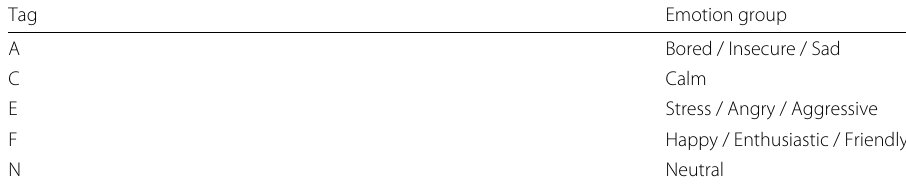
Table 3 Emotion groups abbreviations Tag